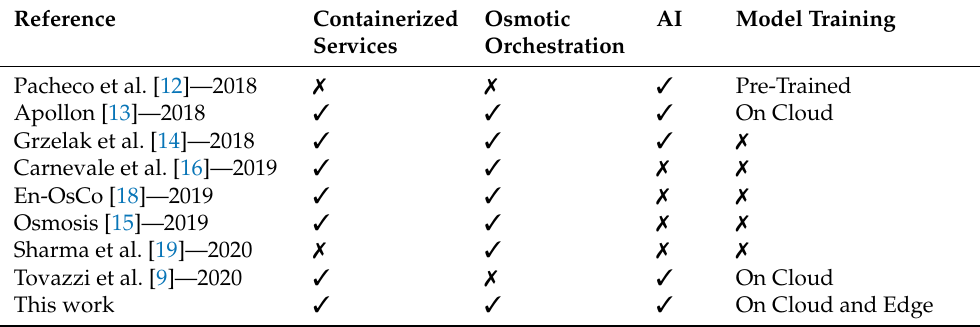
Table 1. Comparative table of frameworks ( (cid:51) : supported, (cid:55) : not supported).